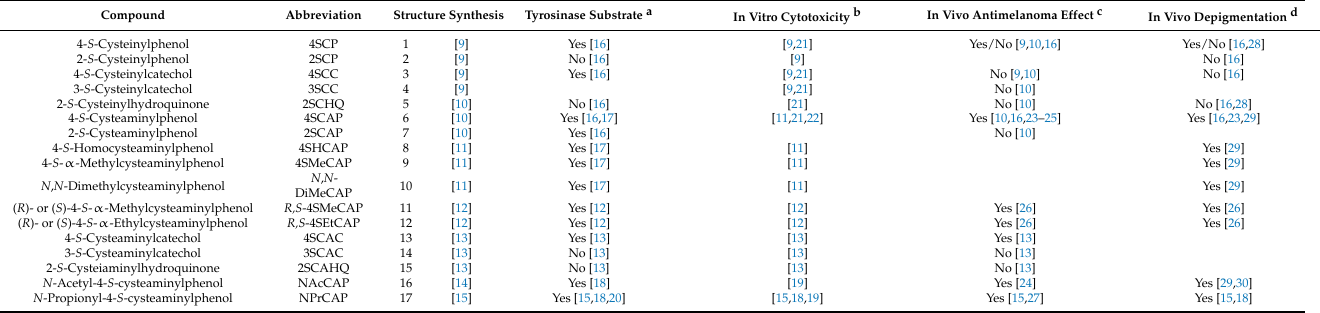
Table 1. Phenolic thioethers synthesized and evaluated for antimelanoma and depigmenting